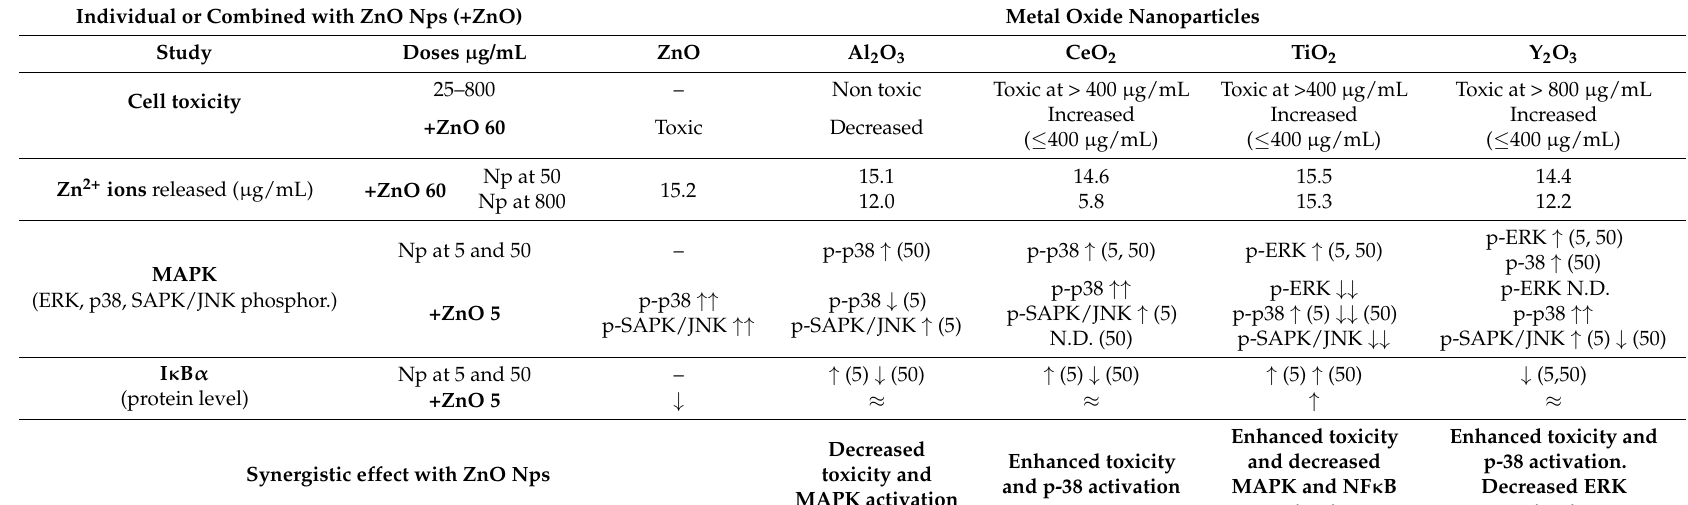
Table 1. Summary of the results observed with the metal oxide nanoparticles and their combination with ZnO nanoparticles in Jurkat cells. Individual or Combined with ZnO Nps